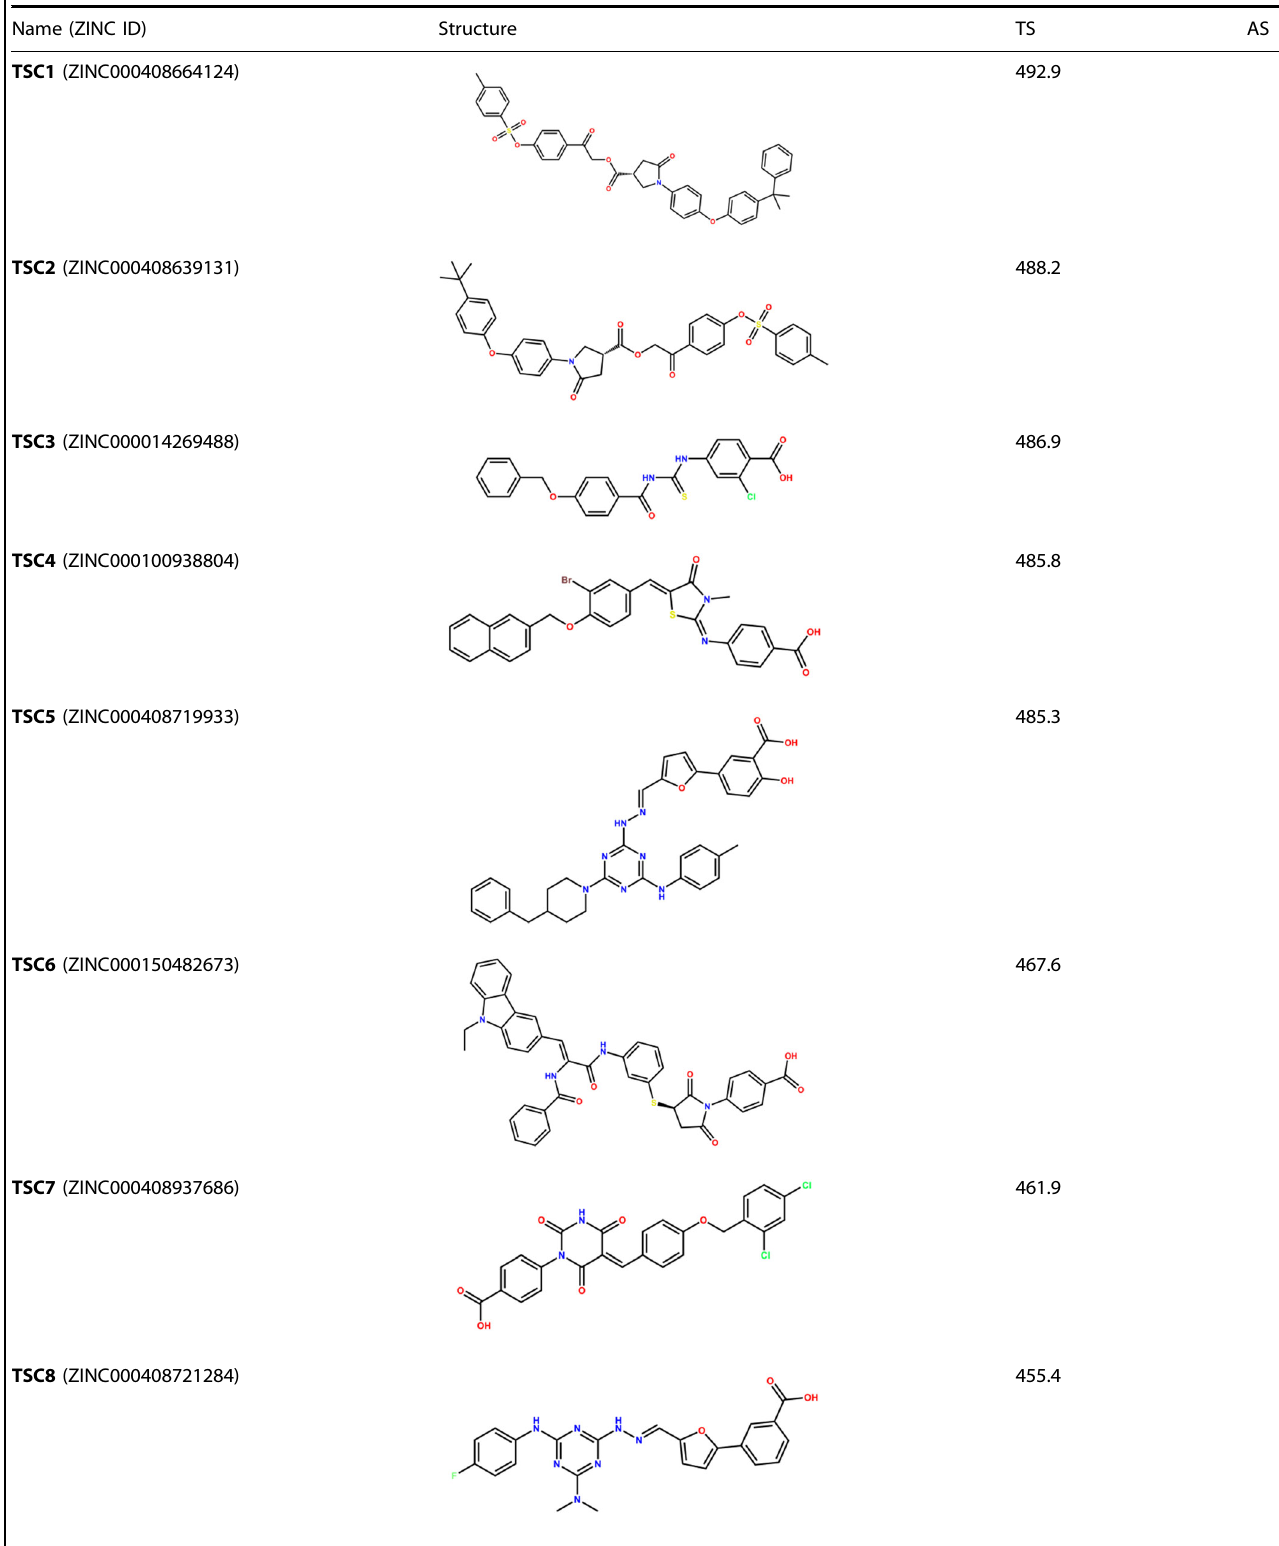
Table 6. The ten compounds with the best TS and AS scores (TSC1-10 and ASC1-10,